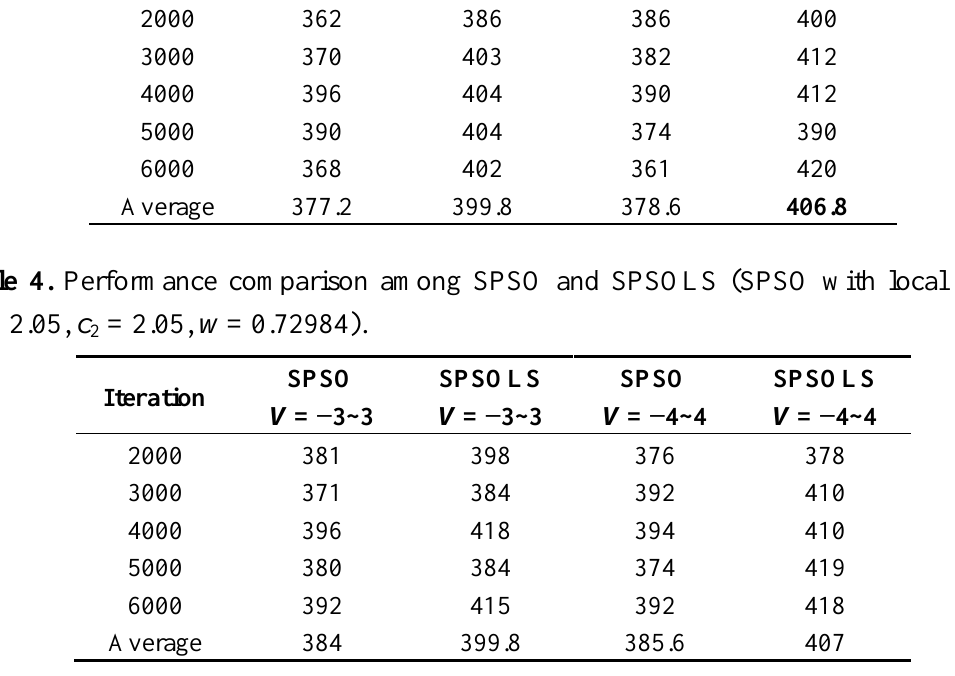
Table 5. Performance comparison among SPSO and SPSOLS ( c